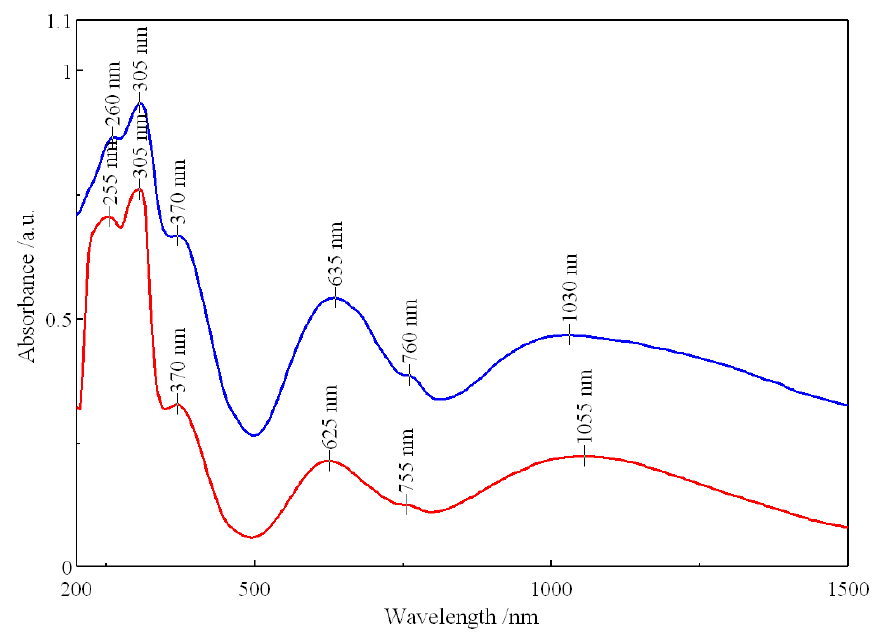
Figure 4. UV-Vis-NIR spectra of [Ni(bpy)(acr) 2 (H 2 O)]·MA (blue) and [Ni(bpy)(acr) 2 (H 2 O)] (red). The spectrum of 1 is slightly different from that of the precursor concerning the bands corresponding to the spin-allowed transitions 3 A 2g → 3 T 2g (1055 nm) and 3 A 2g → 3 T 1g (625 nm), as well as the spin-forbidden transition 3 A 2g → 1 E g (755 nm) [25]. This comes from the different ligand arrangement, bond lengths and angles, which are all induced by interaction with